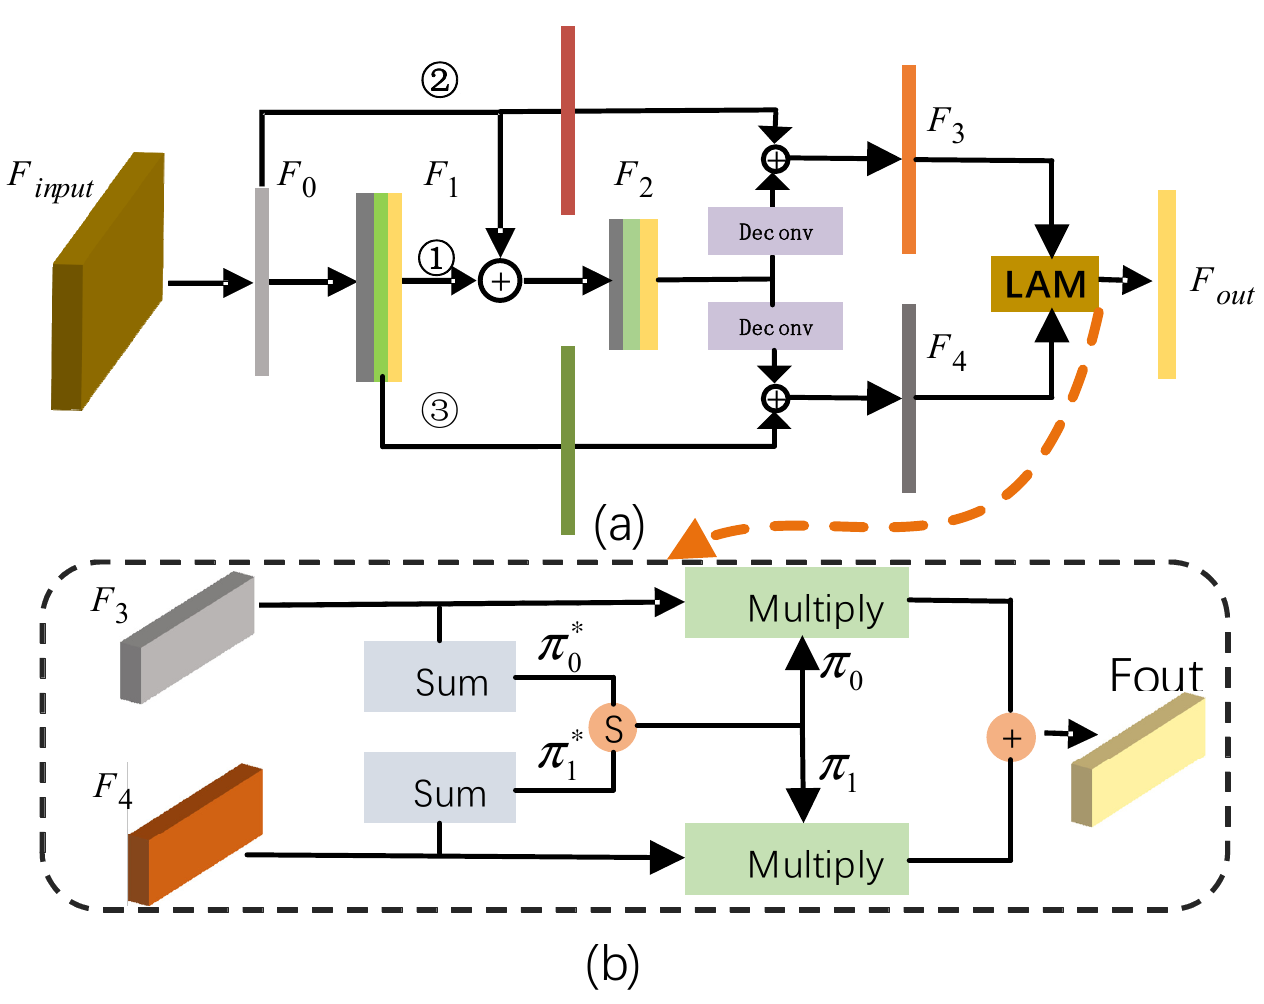
Figure 5. The structure of the LLM module. ( a ) Feature reuse module. ( b ) Location attention module for multi-layer feature fusion.